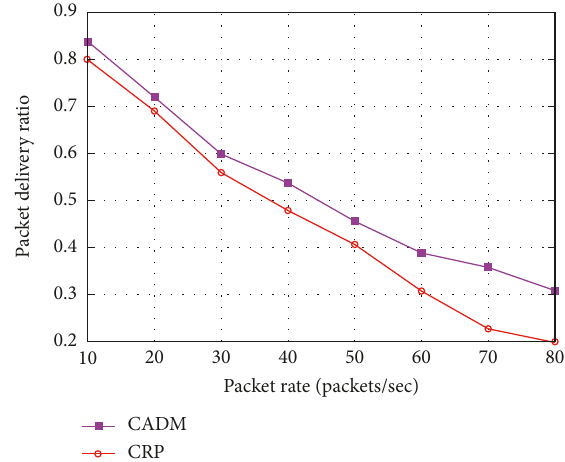
Figure 4: Packet delivery ratio (PDR) with varying packet